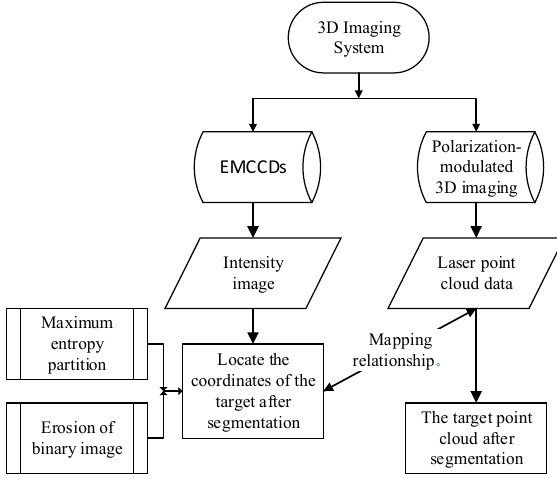
Figure 2. Proposed of segmentation methodology.